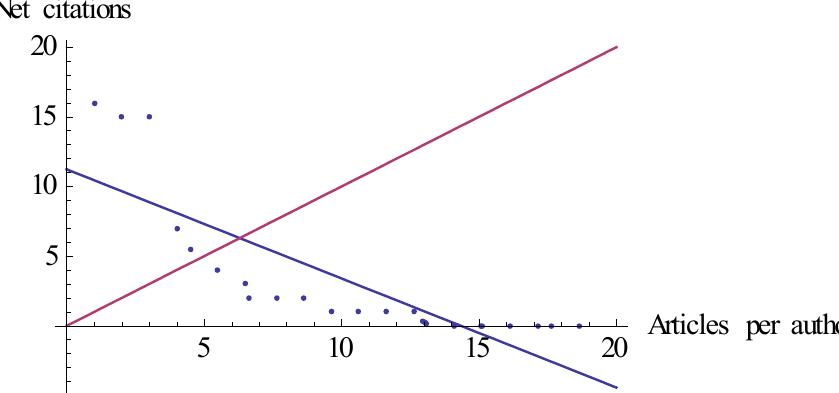
Figure 1. Least-squares linear interpolation fitting for the H index per author (i.e., scientific production): H ltn = 6.29 ( R 2 = 0.66; regression sum of squares = 389; sum of squares for the residuals = 195; F (2, 22) = 44 ( p < 0.001) with 2 parameters and 24 observations). The red increasing line represents y = x ; the blue decreasing line represents the fitted curve. Abbreviations: l = linear interpolation; t = total number of publications and citations in the period 1995 to 2016; n = net citations.